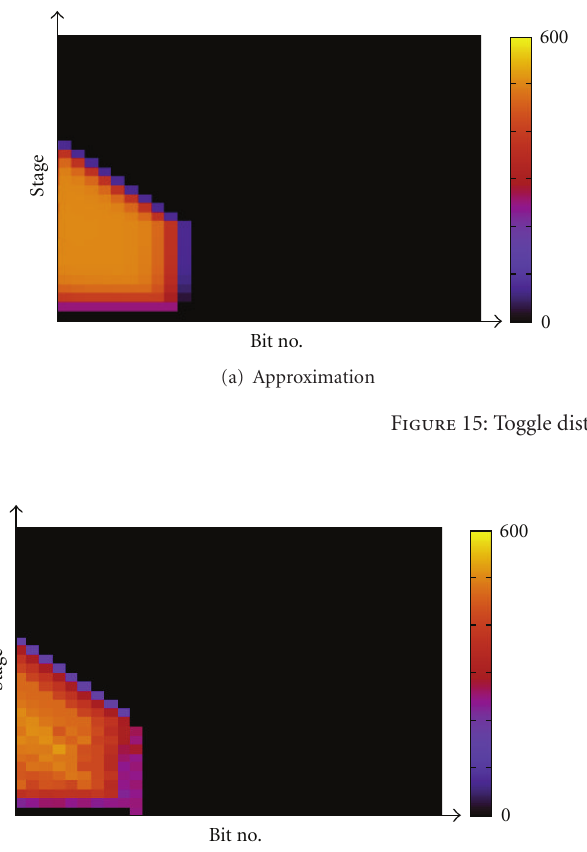
Figure 16: Reference from XPA